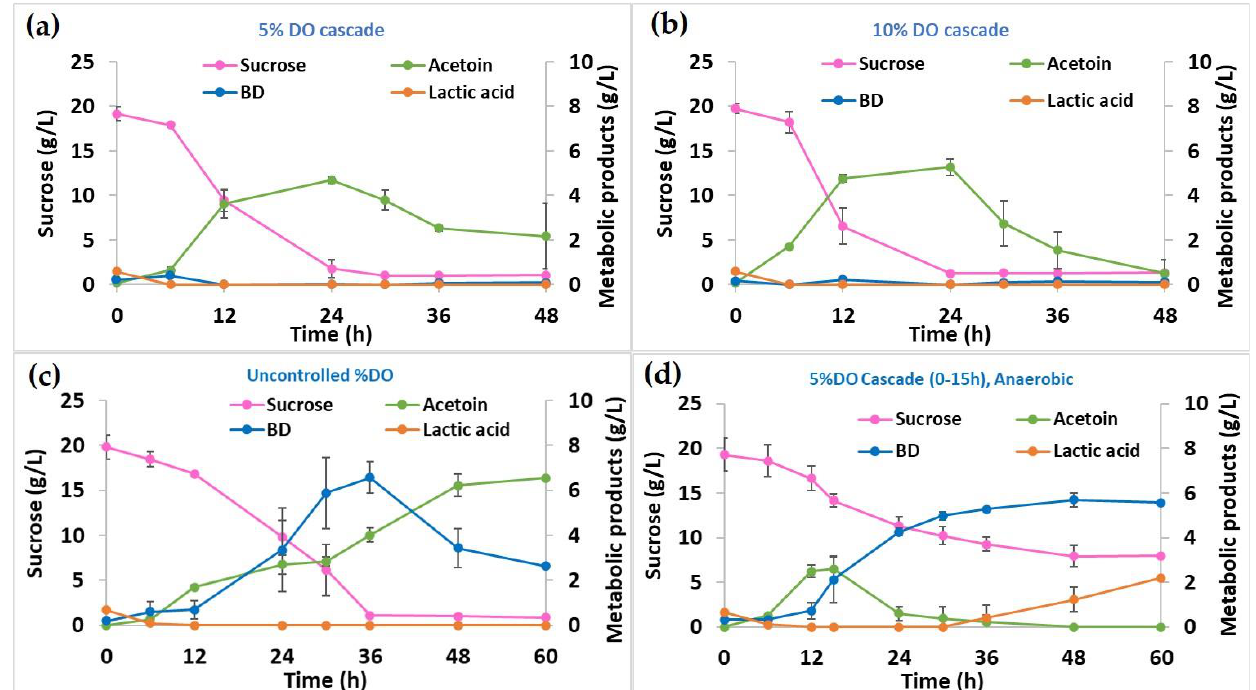
Figure 2. Time courses of substrate utilisation and production of metabolic products by B. subtilis from sucrose-based medium in 2 L bioreactor at 30 ℃ pH 6, aeration rate 1.0 vvm under (a) controlling DO with cascade agitation at 5%, (b) controlling DO with cascade agitation at 10%, (c) uncontrolled DO at fixed stirrer speed at 180 rpm throughout fermentation, (d) controlling DO with cascade agitation at 5% during the first 15 h, followed by anaerobic conditions.